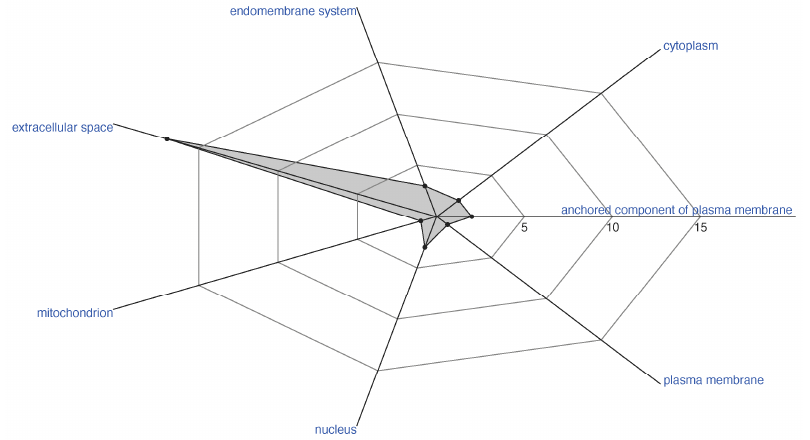
Figure 3. Distinct subcellular location of detected enterotoxins of the entomopathogenic fungi Ophiocordyceps australis . Dots and shadowed areas in the radar plot proportionally depict the number of enterotoxins in each subcellular location.